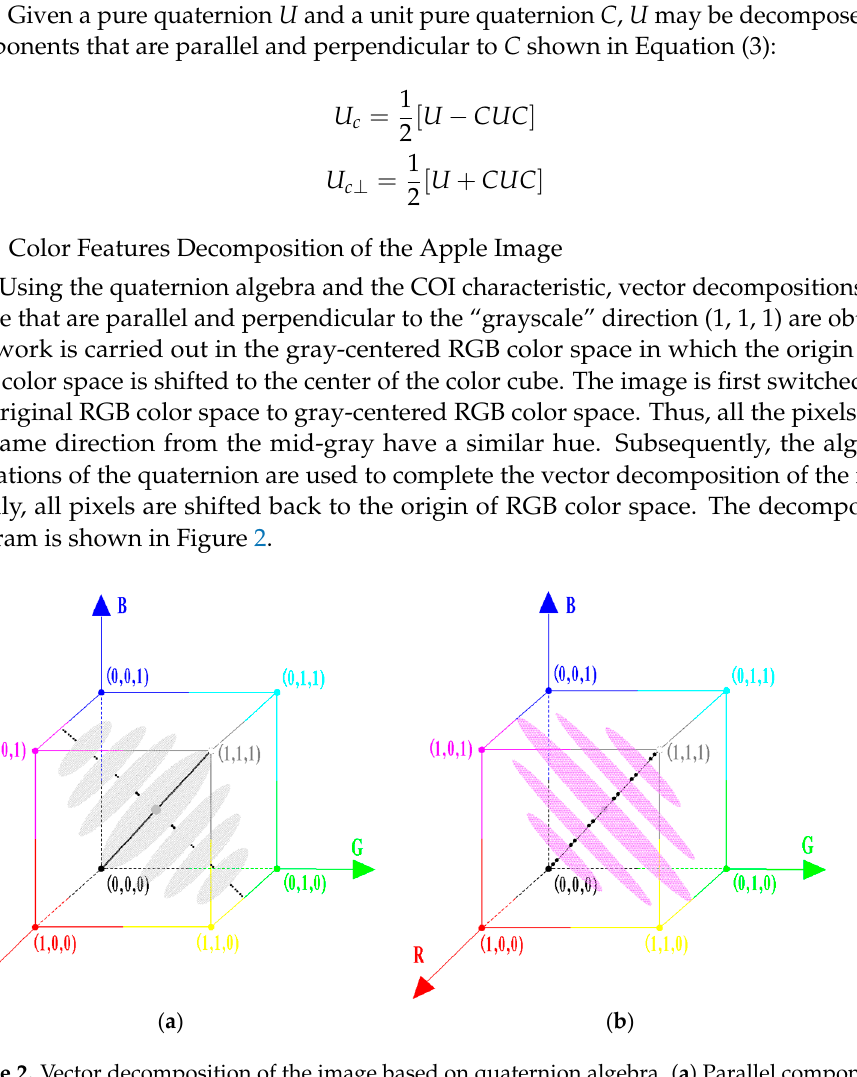
Figure 2. Vector decomposition of the image based on quaternion algebra. ( a ) Parallel components to (1, 1, 1). ( b ) Perpendicular components to (1, 1, 1).